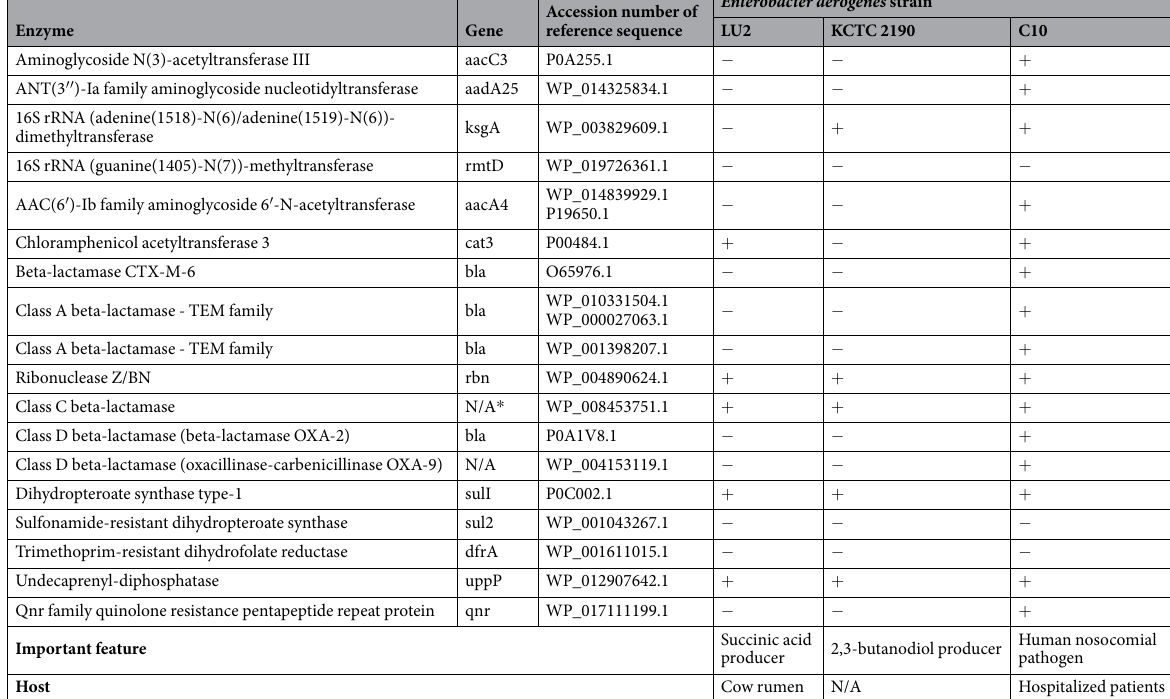
Table 2. Comparison of resistance related-genes presence in Enterobacter aerogenes LU2, KCTC 2190 and C10 strains. * N/A- no data available.